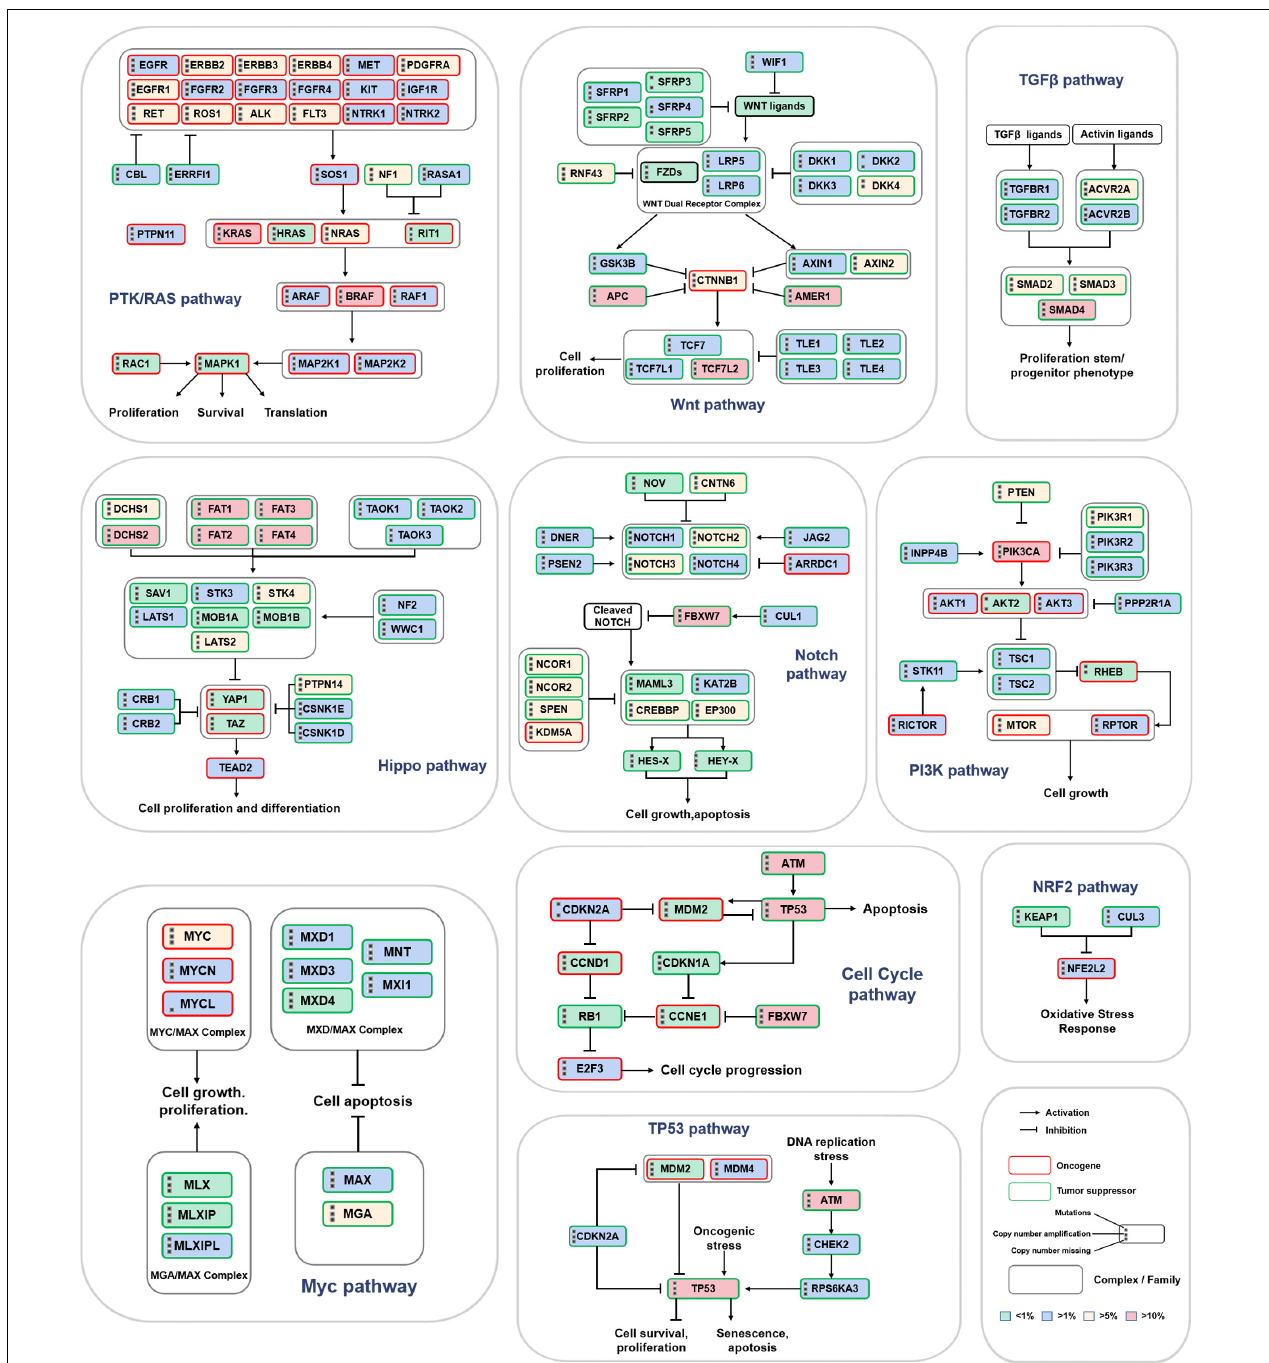
FIGURE 5 | Mutation frequency of key genes in 10 classic signaling pathways. The three black dots on the left side of the gene name represent gene mutations, copy number amplifications and deletions. The red border represents oncogenes, and the green border indicates tumor suppressor genes. The intensity of the color represents the mutation